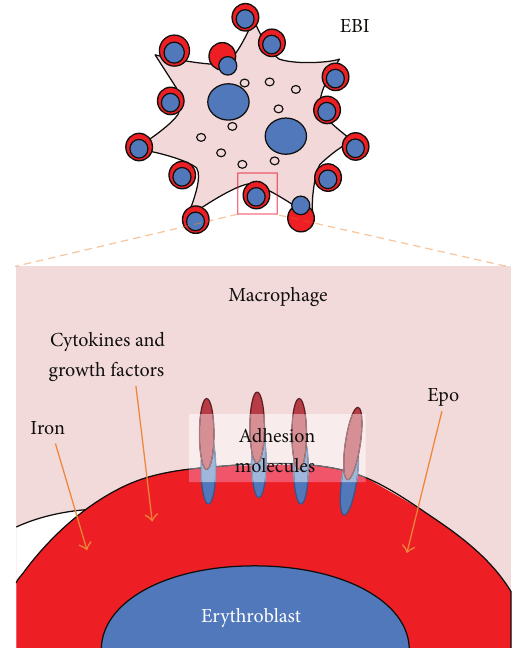
Figure 4: The erythroblastic island provides a niche for erythroid development. Central macrophage anchors erythroblasts in the erythroid niche via adhesion molecules. Within the EBI, the central macrophagesupportserythropoiesisinseveralways,suchasprovid- ing iron for haemoglobin synthesis, cytokine, and growth factors as well as engulfing expelled erythroid